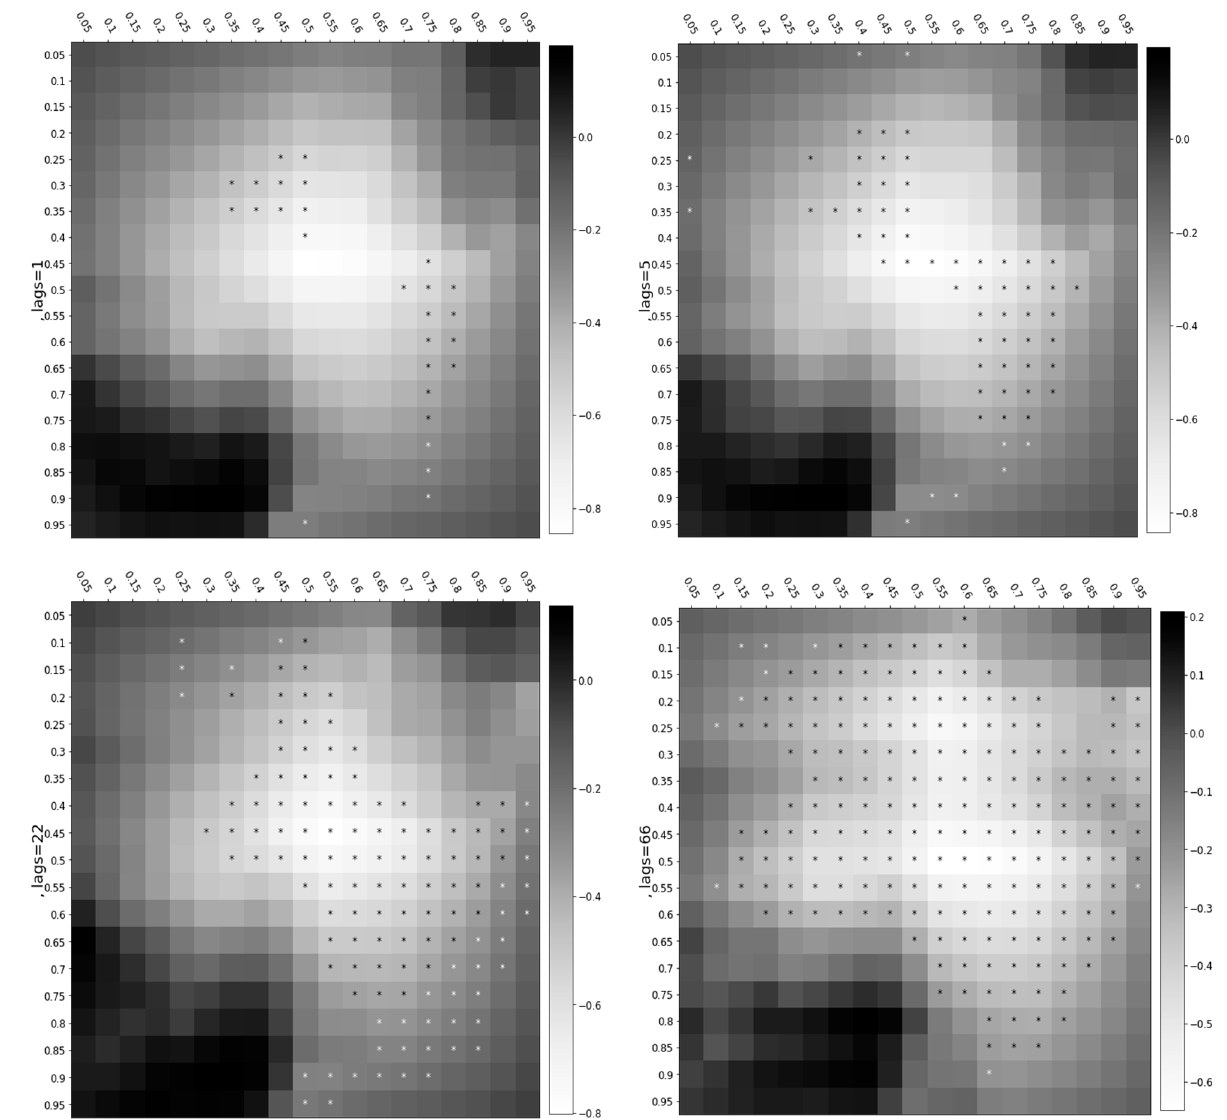
Figure 11. Cross-quantile dependency from Moderna to Sinopharm. Notes: The vertical axis indicates the quantile distribution of Moderna’s stock return, whereas the horizontal axis indicates the quantile distribution of Sinopharm’ stock return. The white-to-black intensity in the bar indicates negative to positive associations.